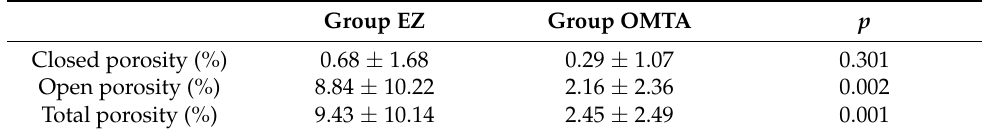
differ among the three obturation techniques ( p > 0.05, Table 5). Table 4. The percentage volume of porosity (%) in group EZ and OMTA. * Interaction between two factors. Table 4. The percentage volume of porosity (%) in group EZ and OMTA.